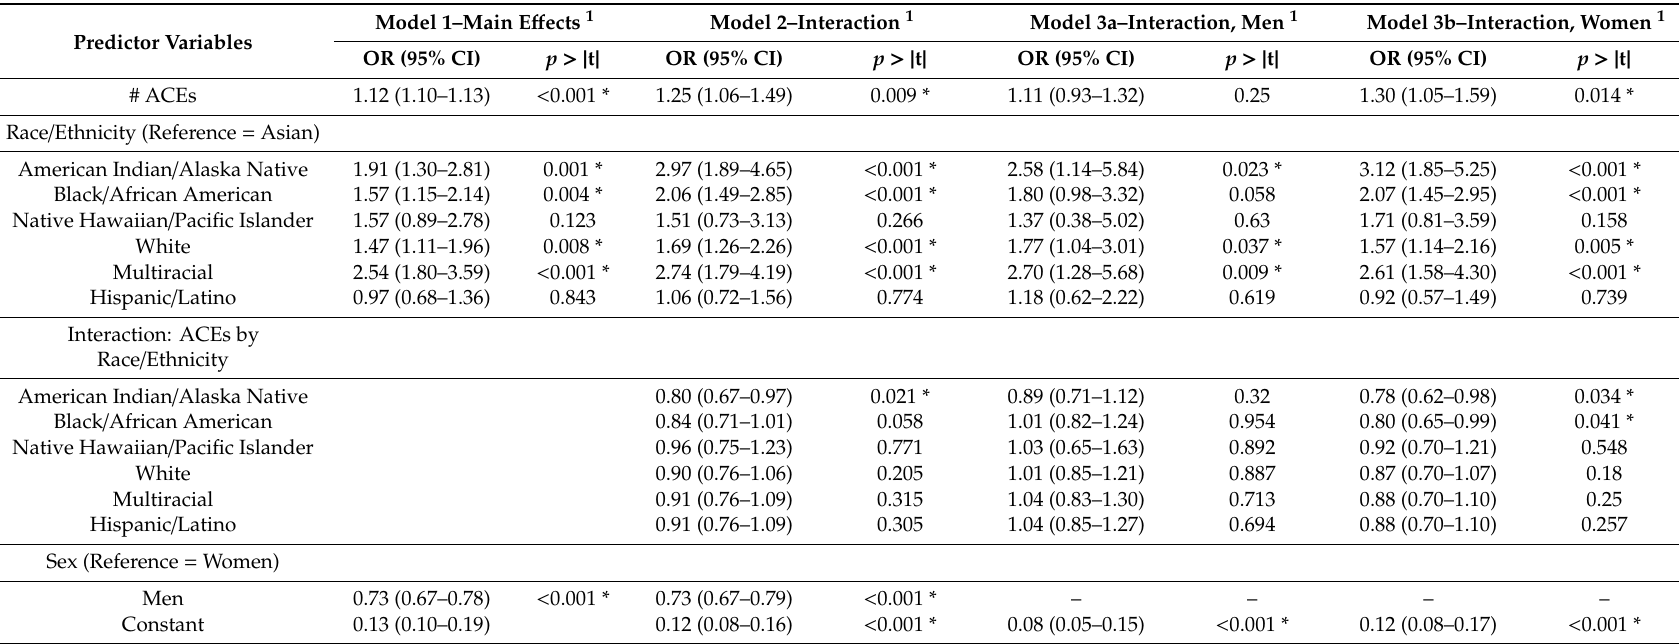
Table 4. Overall and sex-stratified logistic regression for asthma predicted by number of adverse childhood experiences and race / ethnicity, adjusting for interaction between ACEs and race / ethnicity, covariates, calculated using Behavioral Risk Factor Surveillance System 2009–2012 data. Predictor